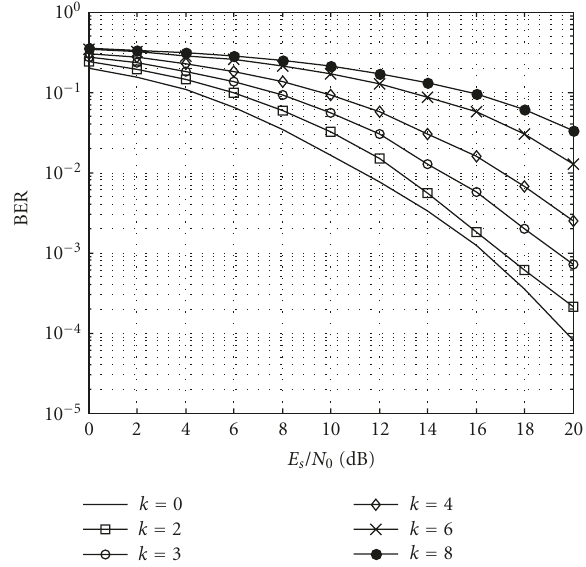
Figure 4: Performance of VBLAST for various line of sight